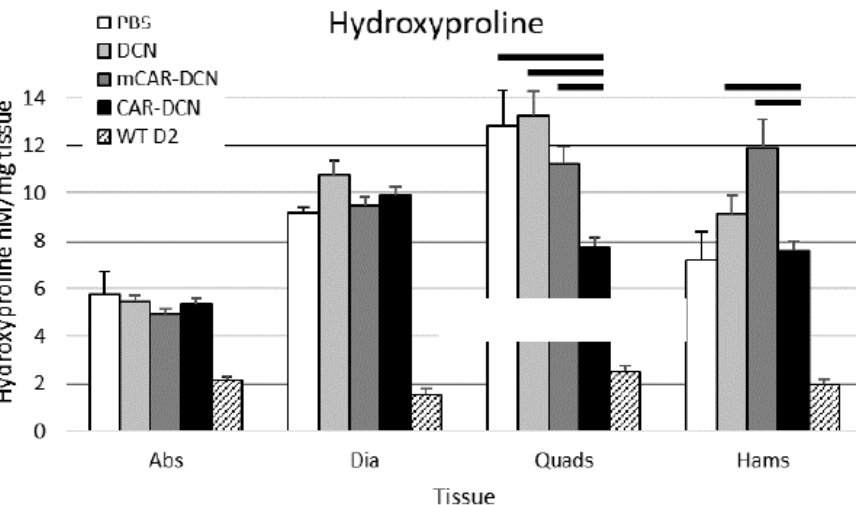
Figure 9. Three weeks of CAR-DCN treatment decreased fibrosis as measured by the hydroxyproline content assay in the canonical skeletal muscle tissues. Abs, abdominals; Dia, diaphragm; Quads, quadriceps; Hams, hamstring. Data represent mean ± SEM. Solid lines indicate statistical significance ( p < 0.05). n = 7, 11, 10, 10 animals, respectively.